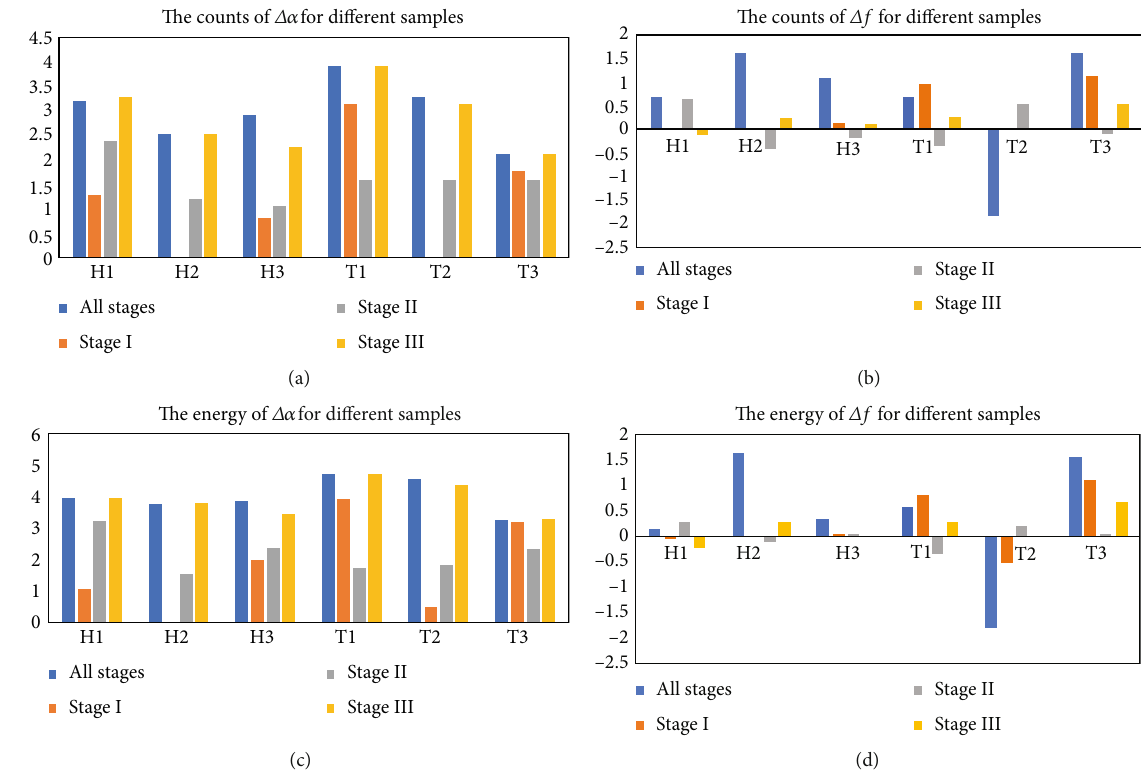
Figure 11: Values of Δα and Δ f for the di ff erent samples at di ff erent stages. (a, b) Corresponding to Δα and Δ f of the AE counts. (c, d) correspond to Δα and Δ f of the AE energy. Table 4: Types of time-frequency characteristics of AE